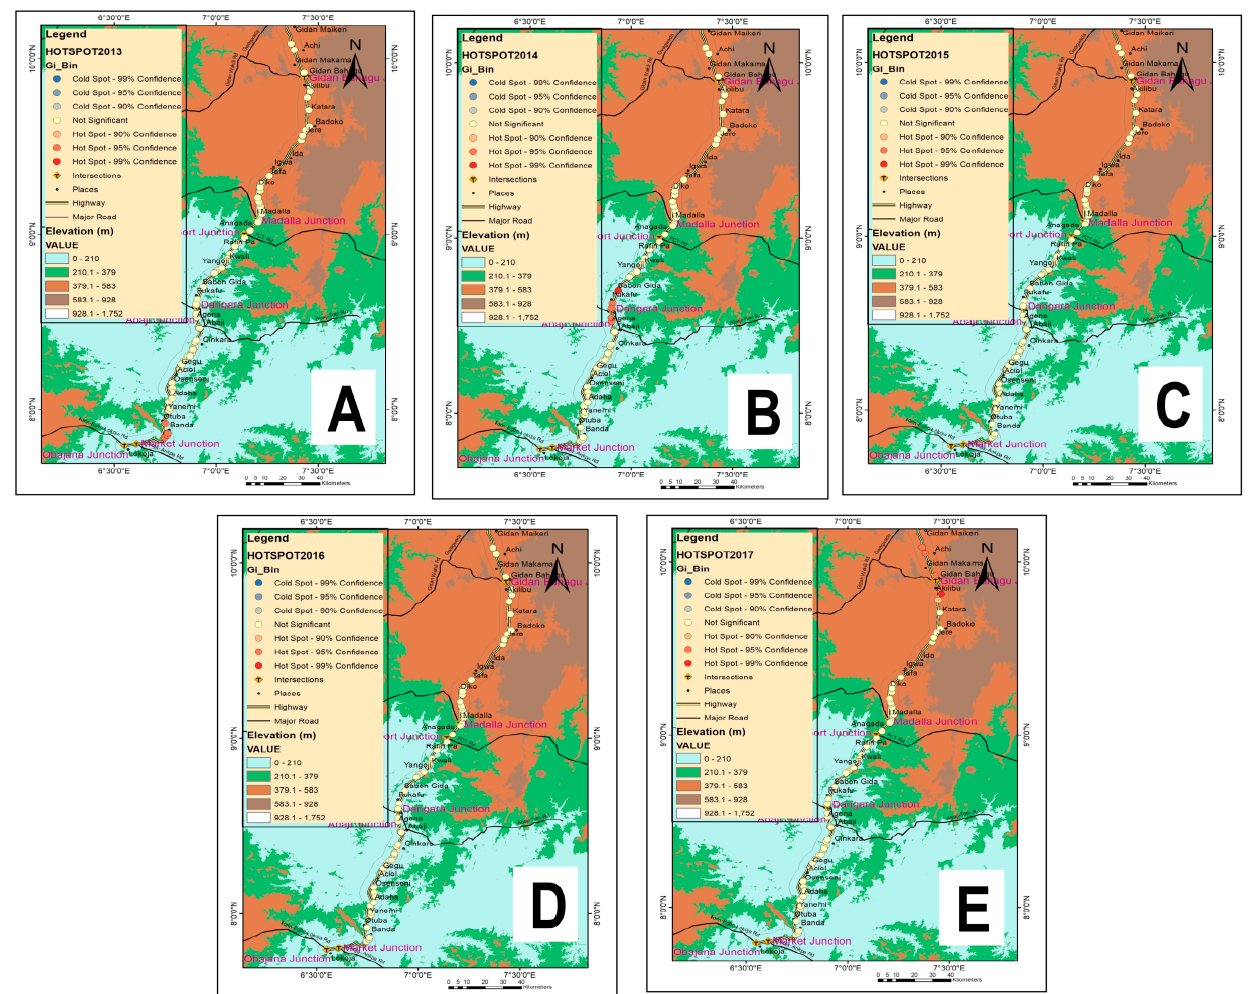
Figure 5. Hotspot analysis: ( A ) Year 2013: hotspot exits with a 95% significance, ( B ) Year 2014: hotspot exits with a significance between 95 and 99%, ( C ) Year 2015: no hotspot exits, the pattern is random, ( D ) Year 2016: no hotspot exits, the pattern is random, and ( E ) Year 2017: hotspot exits with a significance between 95 and 99%.